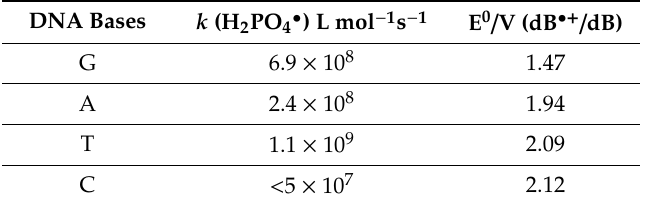
Figure 3. The intermolecular hole transfer reaction between protonated guanine and H 2 PO 4 ˙ formed by direct ionization and H 2 O •+ mediated oxidation in 6 M H 3 PO 4 [44]. Reprinted with permission from [44]. Copyright, 2018, Royal Society of Chemistry. Table 1. Rate constants of the bimolecular reactions of DNA bases with H 2 PO 4 • in 6 M H 3 PO 4 along with standard redox potentials of nucleotide base cation radicals